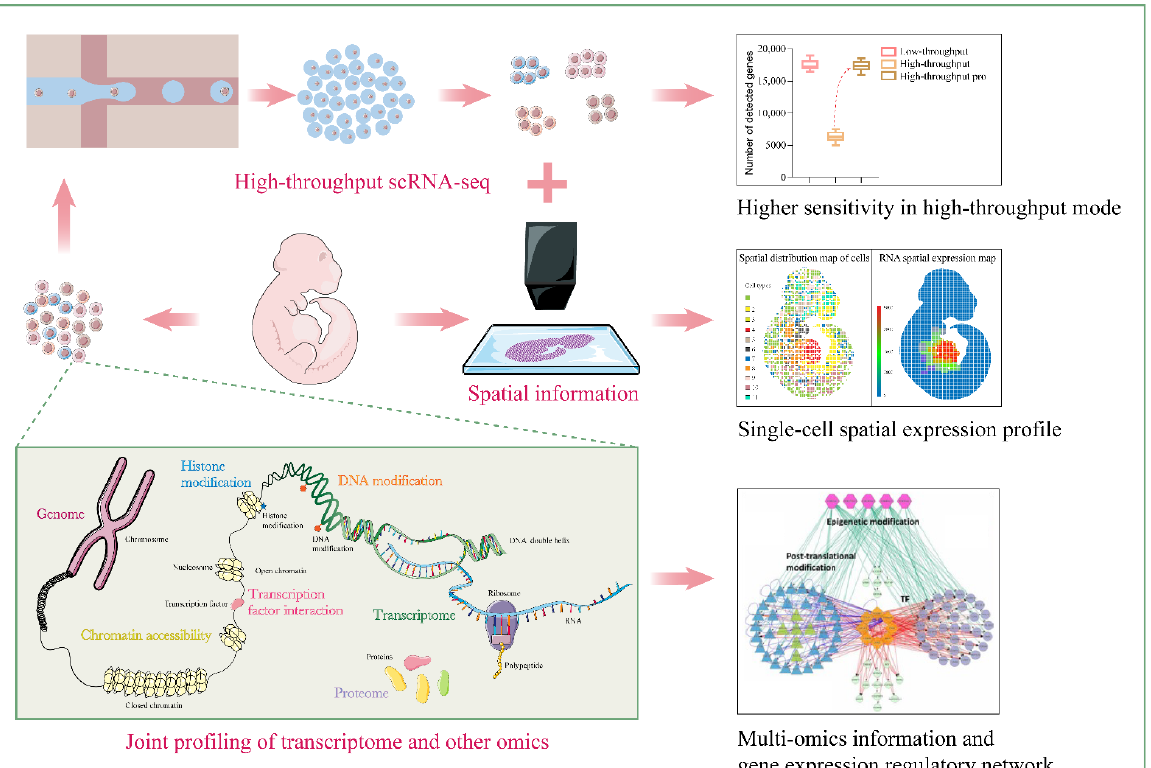
Figure 6. Future outlook of scRNA-seq technology. Gene expression regulatory network at the lower right corner is cited from the article of Guan D, et al. 2014 . Reprinted from ref. [105].